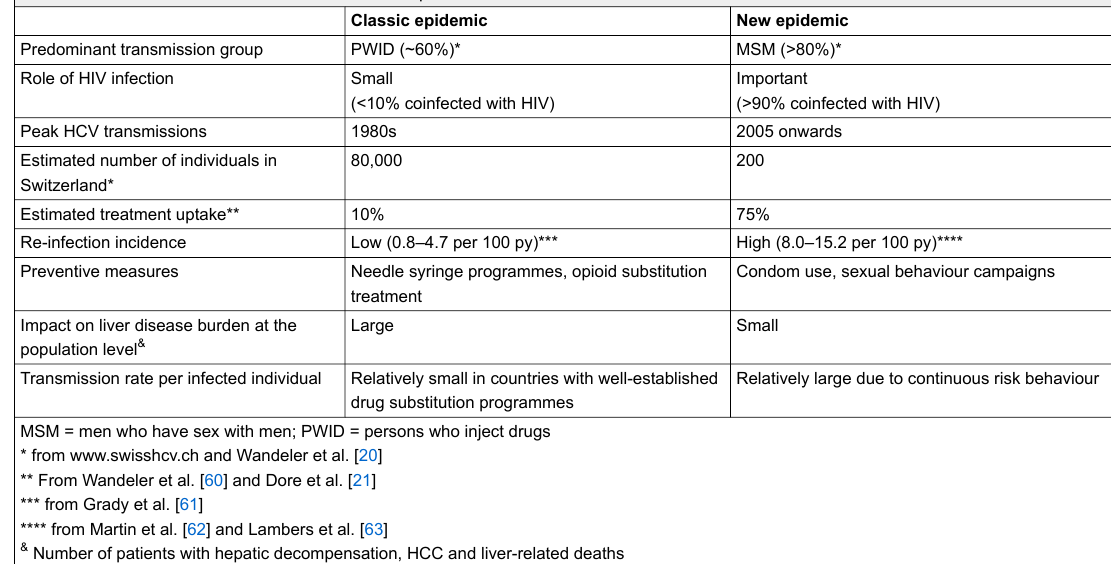
Table 1: Differences between classic and new HCV epidemics in Switzerland. Classic